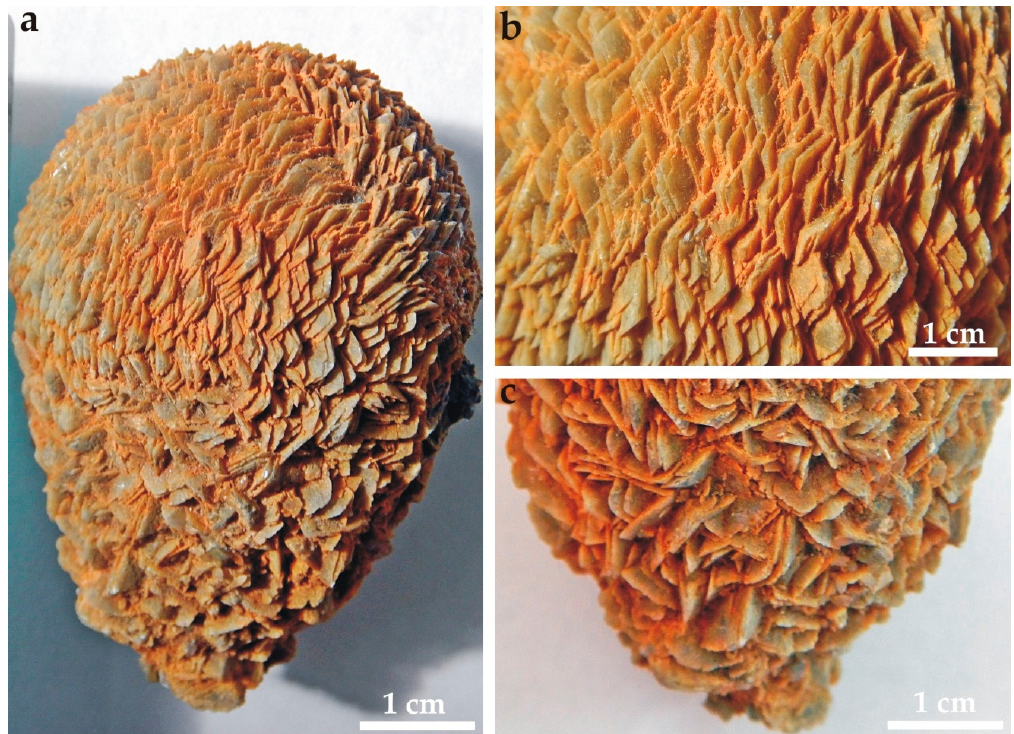
Figure 9. Loose spheroid-like/egg-shaped siderite specimen from Herja (sample RCol2/B; MMBBU). a ) The rounded and elongated shape of the sample reflects the ordered and disordered arrangement respectively of the individual flat rhombohedra siderite crystals; b ) Detail of (a) focused on the rounded section of the sample; c ) Detail of (a) showing the elongated section of the sample with randomly distributed flat rhombohedra siderite crystals.